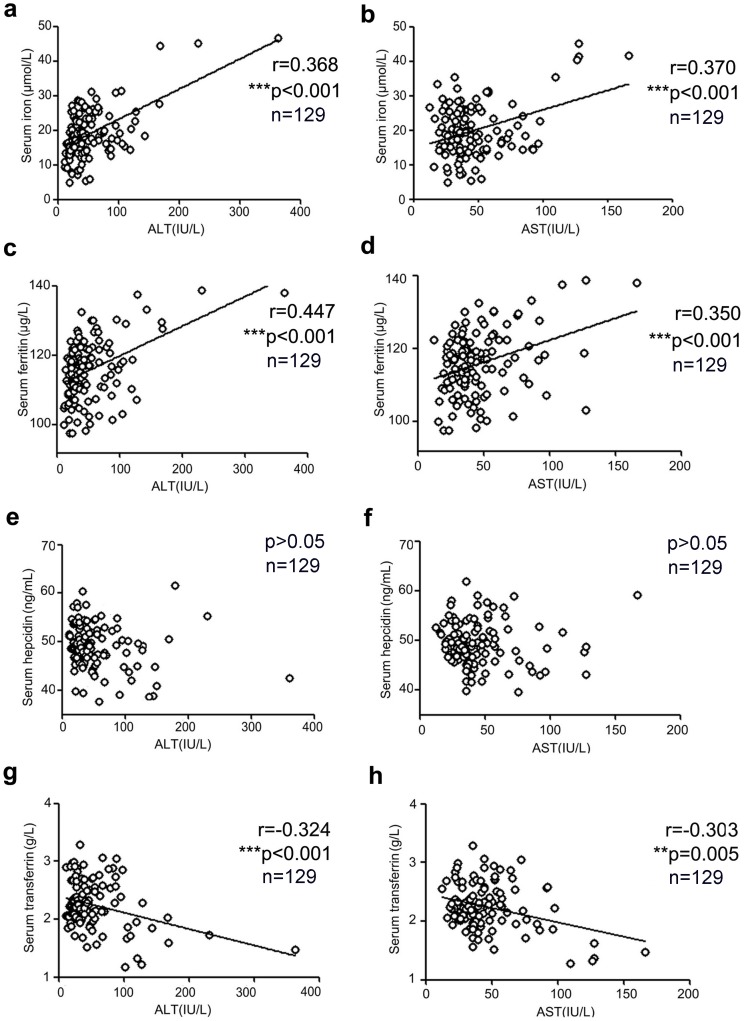
Correlation between serum iron-related parametersand serum ALT (left panel) and AST levels (right panel) in chronically HCV-infected patients.Pearson's or Spearman's tests were used for correlation analysis. A two-sided P<0.05 was considered statistically significant. (*** indicates P values <0.001.).